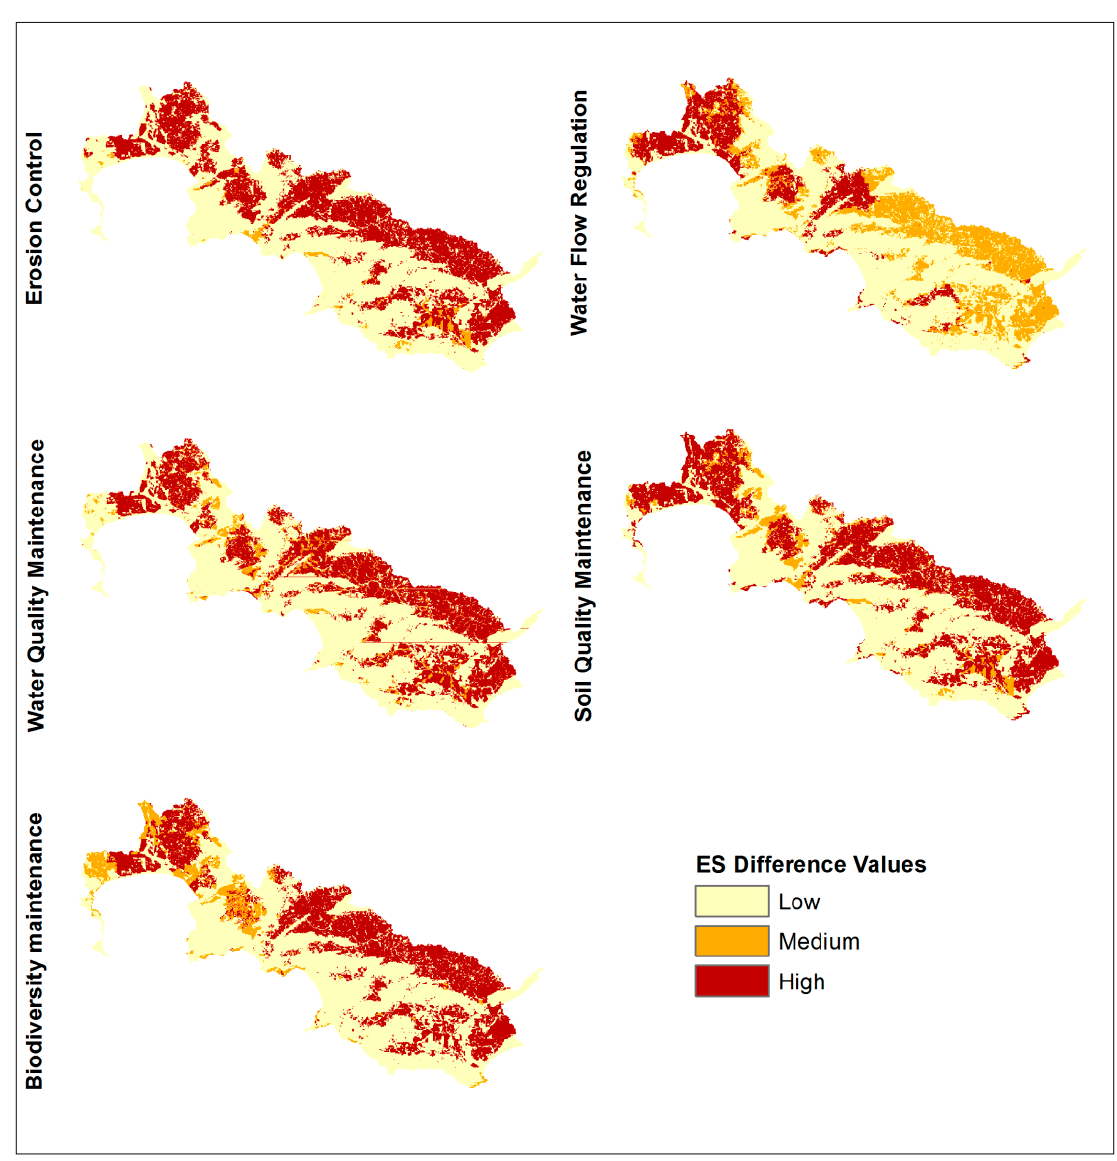
Figure 5. Risk maps showing the ecosystem service difference values from the reference to the LULC situation.